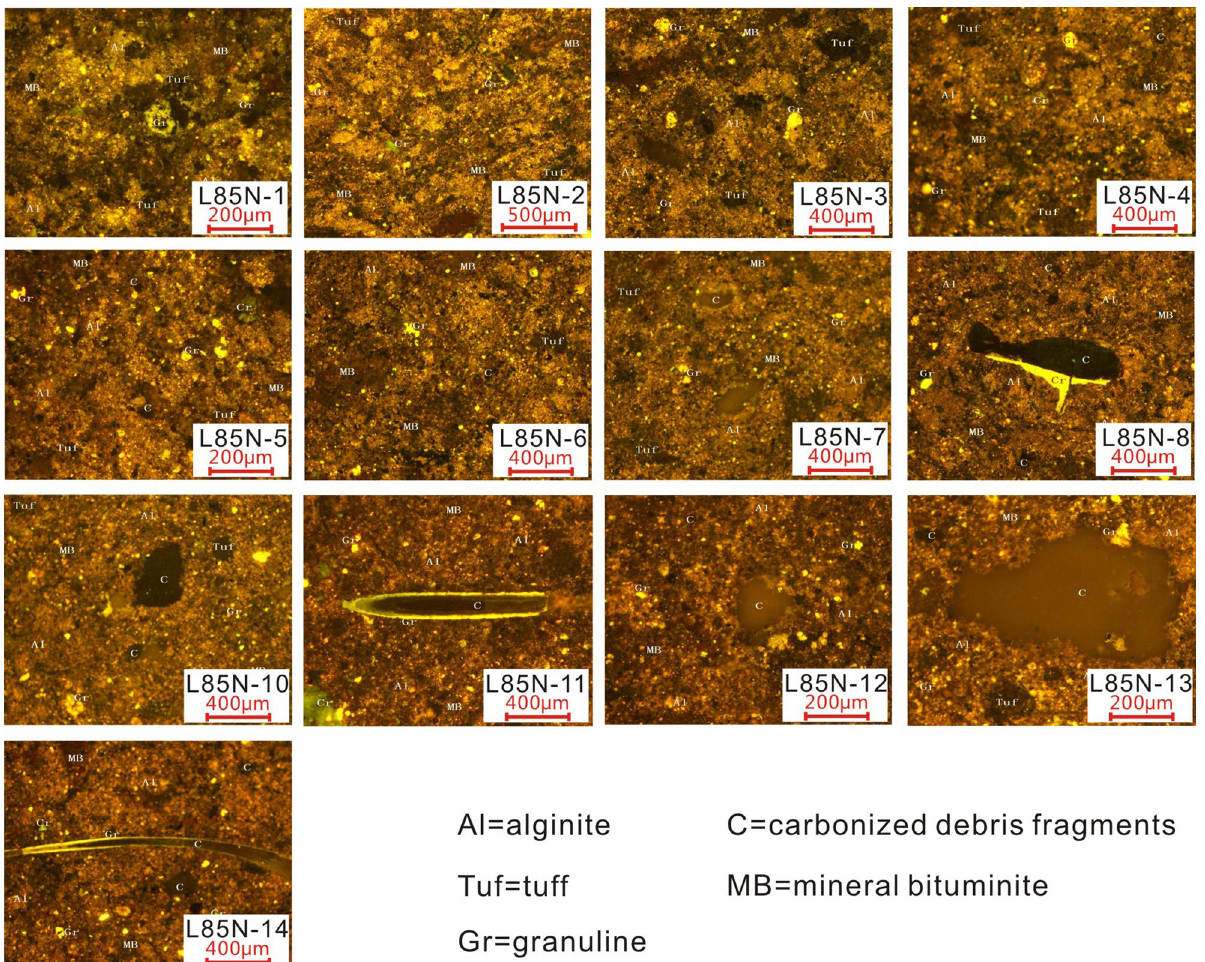
Figure 3. Kerogen macerals for 14 samples. Maceral photographs: L85N-1, alginite is acervate with brown- yellow fluorescence; the mineral bituminite has weak fluorescence as the base. L85N-2, alginite is densely distributed with scattered granuline and tuff debris. L85N-3, alginite is densely distributed. The particles are small, clastic, and enriched in liptinite that contains various sizes of uniformly distributed tuff debris. L85N- 4, micro globular alginite nodules of the same shape and similar sizes are distributed, with more tuff debris. L85N-5, alginite is densely distributed in nodular form. L85N-6, the upper right of the image is part of a carbonized debris without fluorescence, and the lower right is alginite aggregates that are densely distributed, with a small amount of tuff debris. L85N-7, alginite is densely distributed and enriched in a nodular form. L85N-8 and alginite are distributed in a pelletoid form; single particles are fine with blurred shapes. L85N-10, alginite accounts for most of the OM and is densely distributed in groups. L85N-11, massive needle-columnar carbonized debris; alginite is widely distributed. L85N-12, alginite is the principal component of the OM. L85N-13, large and small carbonized debris fragments coexist; alginite is densely distributed. L85N-14, alginite is densely distributed and interbedded with scattered short bands of needle-columnar and granular carbonized debris fragments.